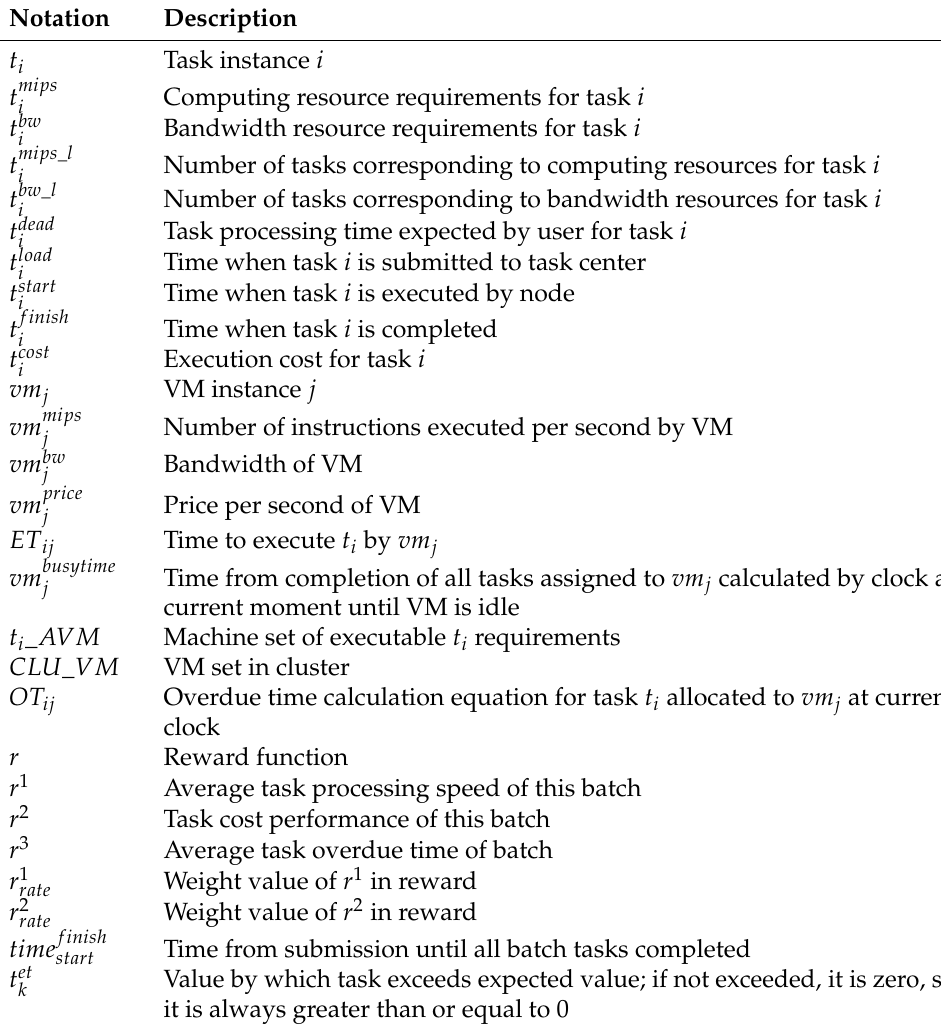
Table 1. Main notation used in this